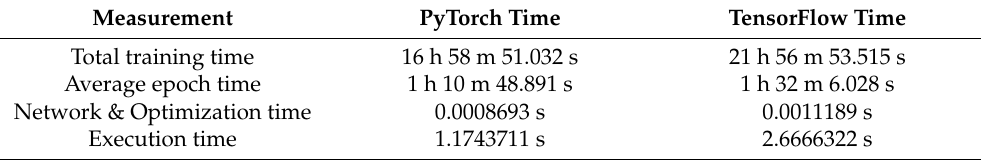
Table 1. Execution times of PyTorch and TensorFlow